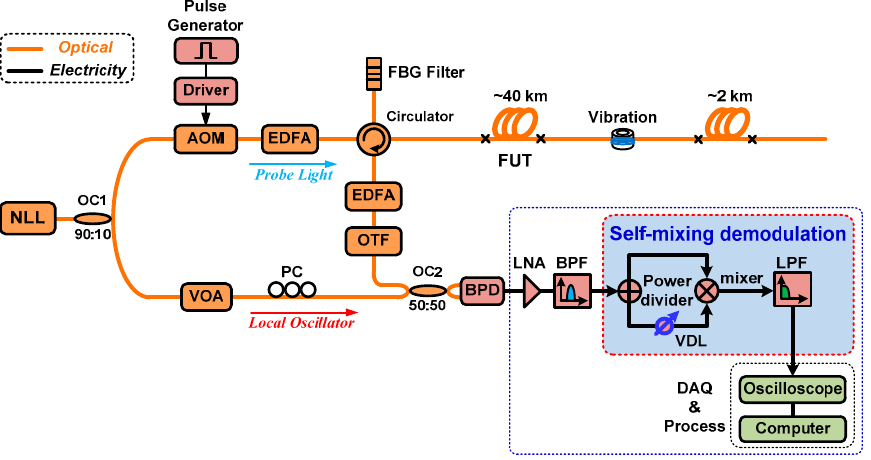
Figure 3. Experimental setup of coherent phase-sensitive OTDR system based on the